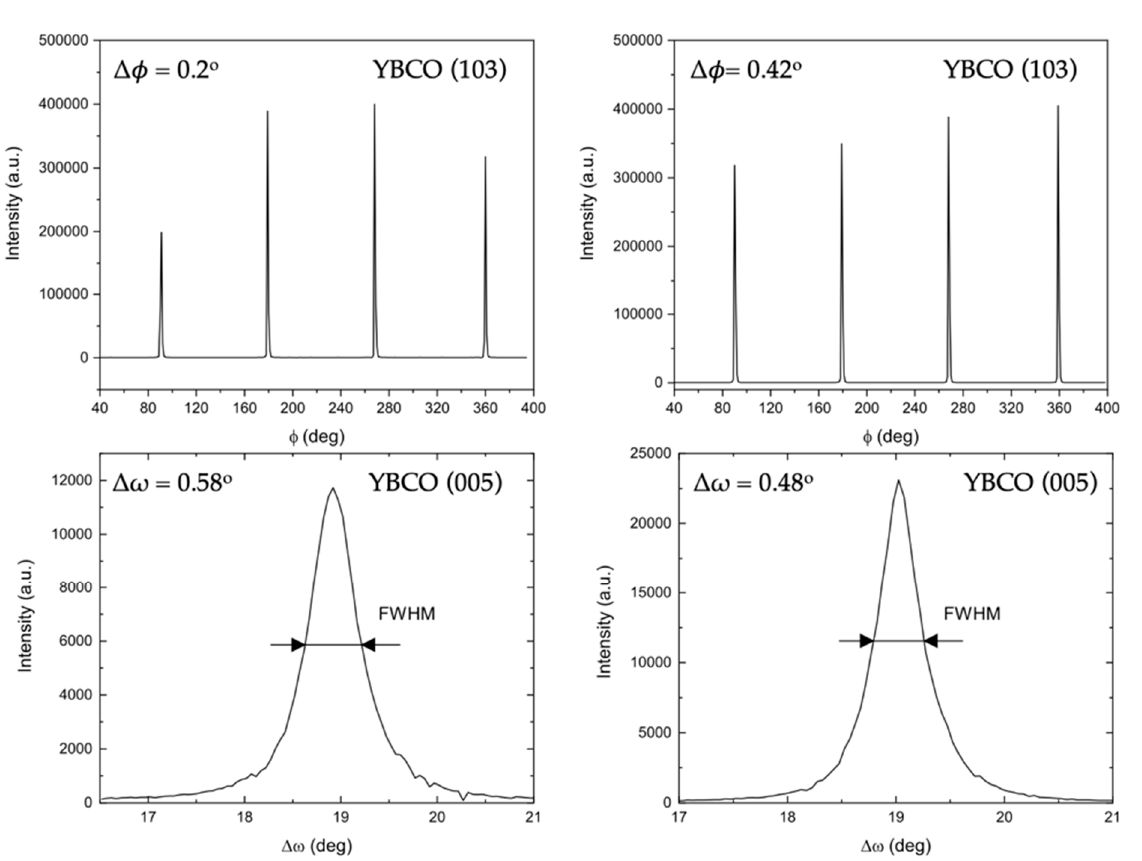
Figure 5. ϕ -scan (103) YBCO and ω -scan (005) YBCO obtained for YBCO films grown at 750 ◦ C with the CTA ( left ) and FH Figure 5. φ -scan (103) YBCO and ω -scan (005) YBCO obtained for YBCO films grown at 750 °C with the CTA ( left ) and ( right ) FH ( right ) methods.